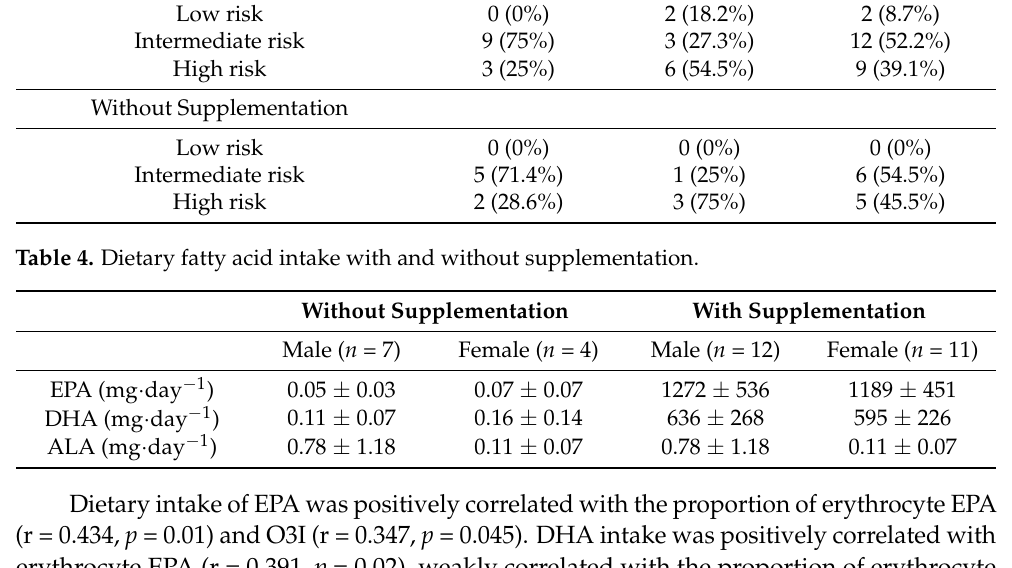
Table 4. Dietary fatty acid intake with and without supplementation.